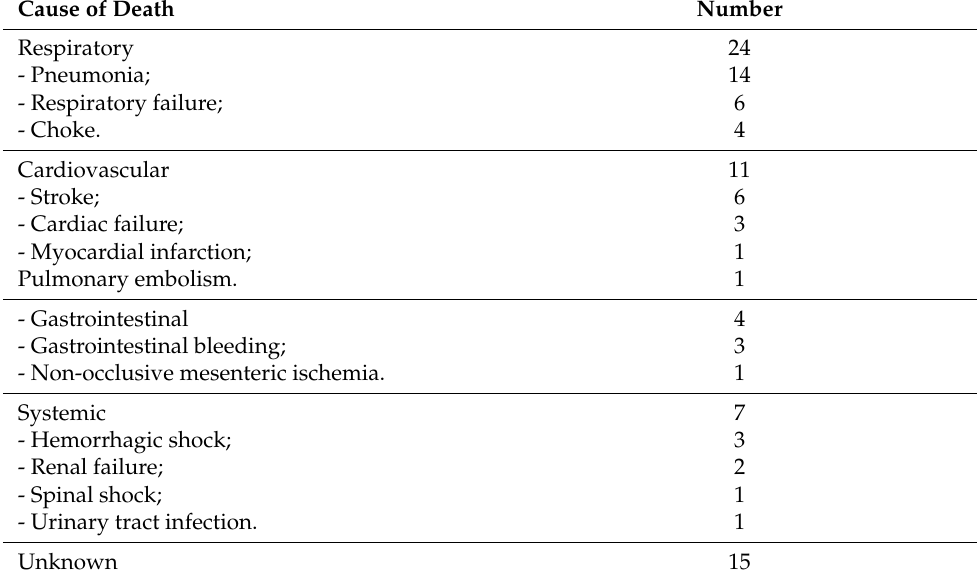
Table 1. Causes of early mortality after traumatic cervical spine injury in older